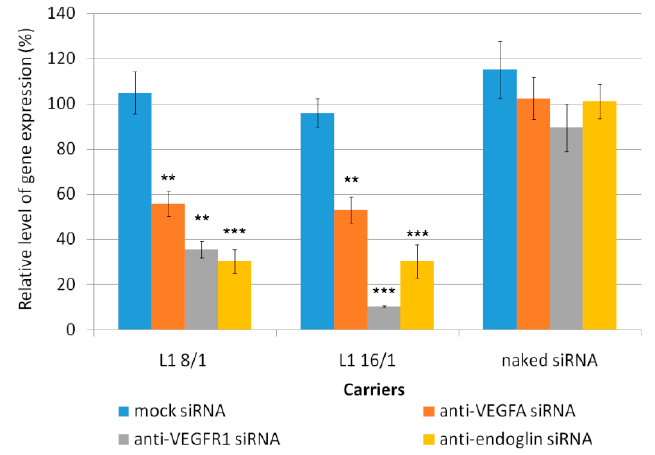
Figure 3. Silencing of VEGFA, VEGFR1, and endoglin gene expression after the treatment of ЕA.Hy926 cells by L1/siRNA polyplexes. ** p < 0.01, *** p < 0.001 when compared with cells treated using L1/mock siRNA polyplexes.